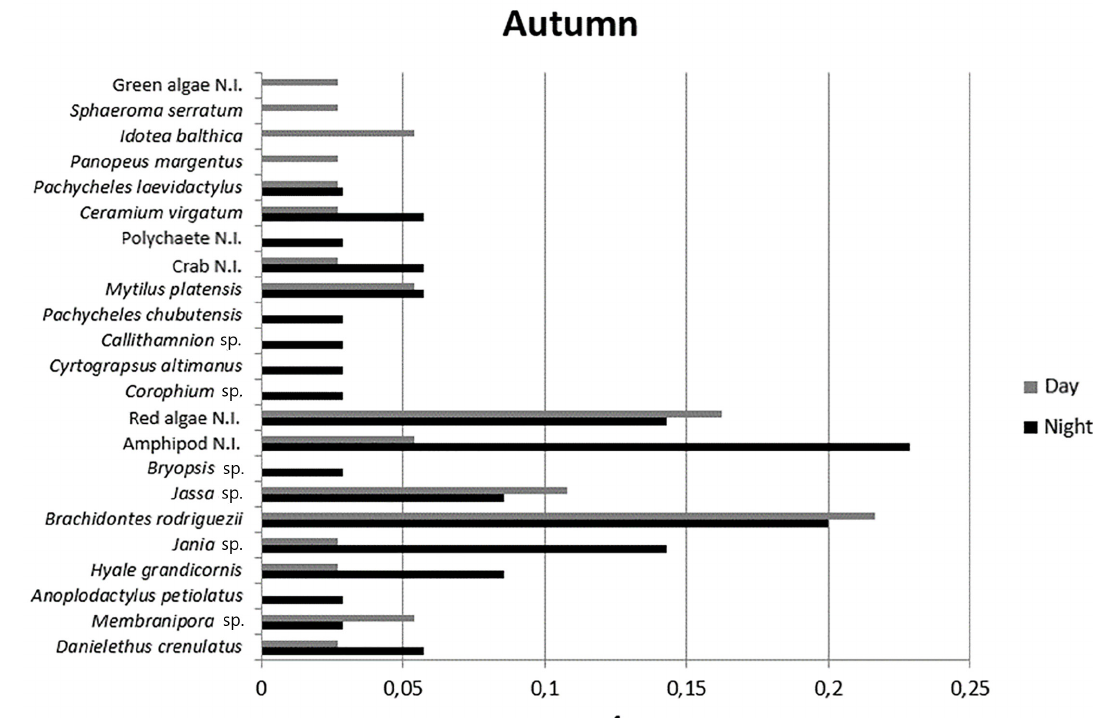
Figure 2. Frequency index of diurnal and nocturnal prey items for Bunodosoma zamponii in autumn. N.I. =